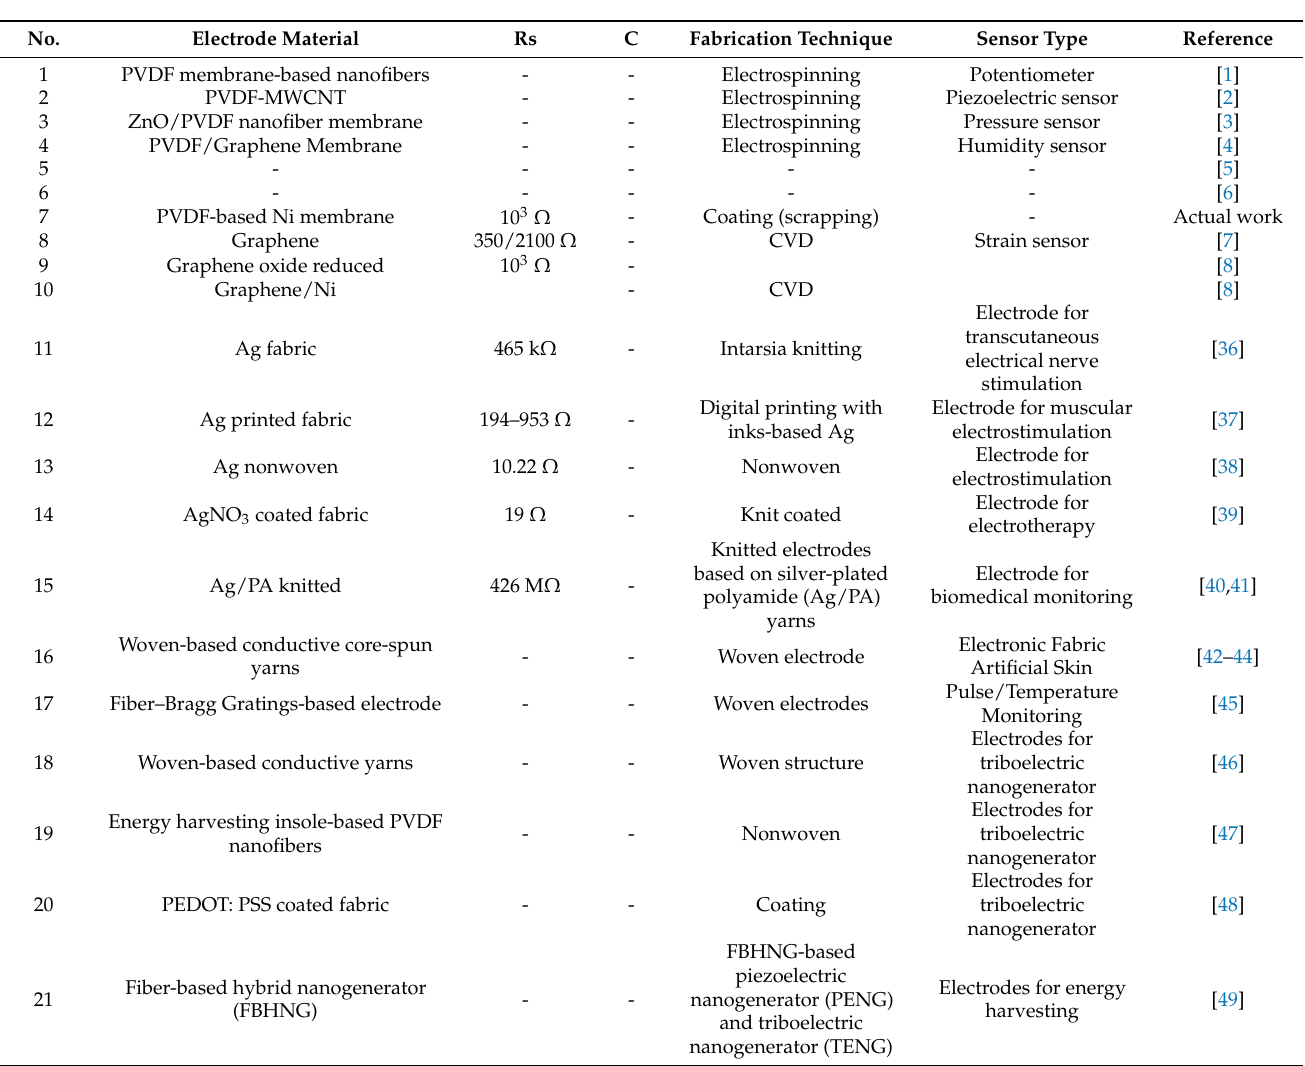
Table 6. Electrode materials for